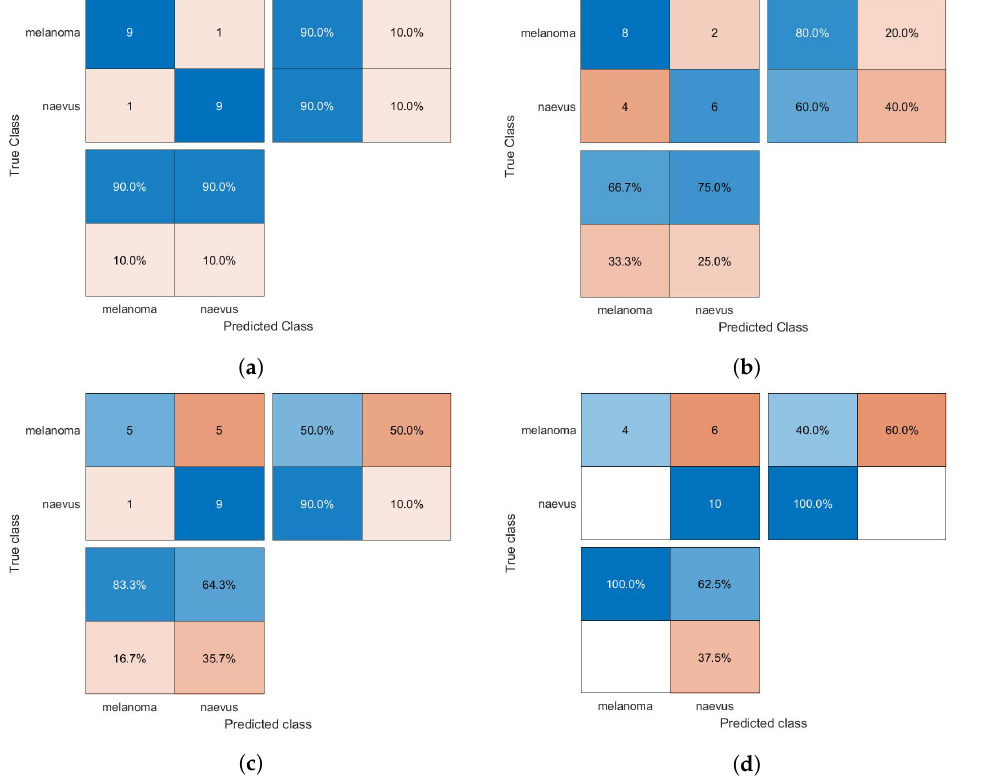
Figure 5. Confusion matrices for the SVM classifier trained using ( a ) HOG, ( b ) CS-HOG, ( c ) LBP, and ( d ) N-LBP